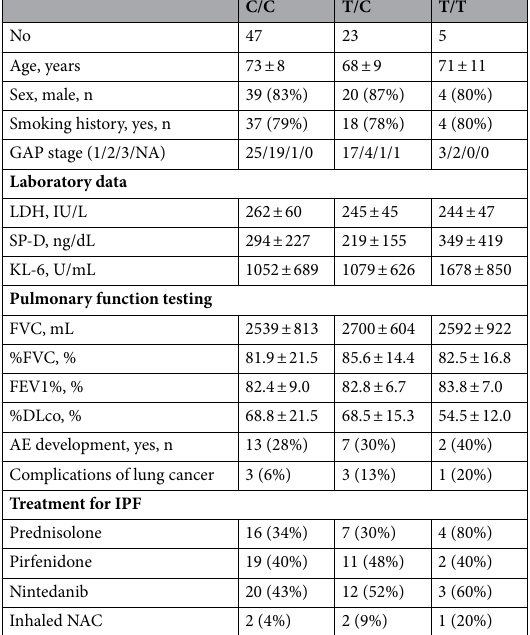
Table 3. Clinical characteristics of IPF patients, by rs3750290 genotype. Data are presented as mean ± SD. IPF idiopathic pulmonary fibrosis, NA not available, GAP gender-age-physiology, LDH lactate dehydrogenase,